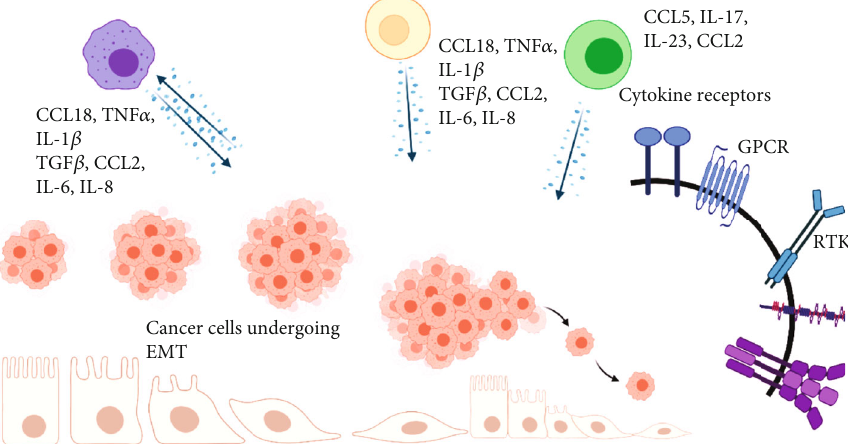
Figure 2: Schematic representation of in fl ammatory molecules released by immune cells that drive EMT. RTK: receptor tyrosine kinase; GPCR: G-protein-coupled